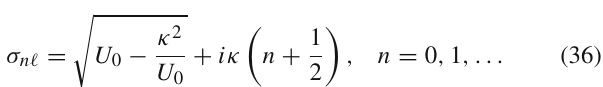
quency computed according to (36), and σ e , PT denotes the QNM in the case of an extreme non-commutative geometry inspired Schwarzschild black hole